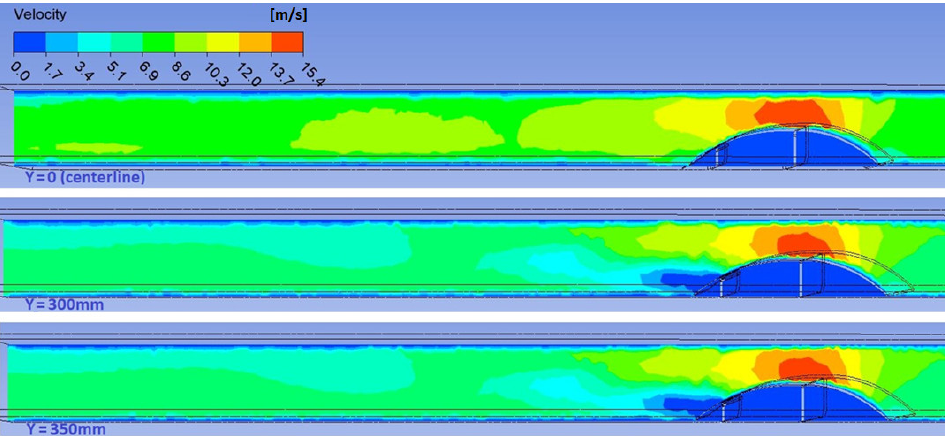
Figure 16. Air velocity; beam with deflector upstream and downstream the beam; longitudinal sections in the centerline, 300 mm and 350 mm from centerline (CFD model with a beam size of 288 mm and an inlet air velocity of 7.9 m/s).